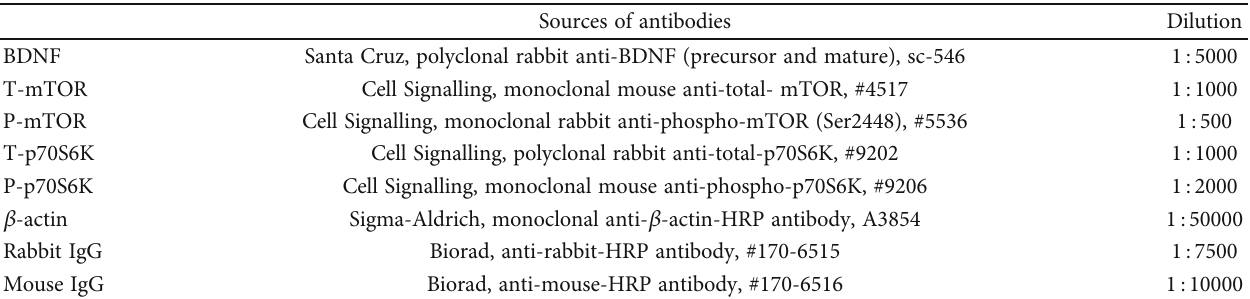
Biorad, anti-mouse-HRP antibody,